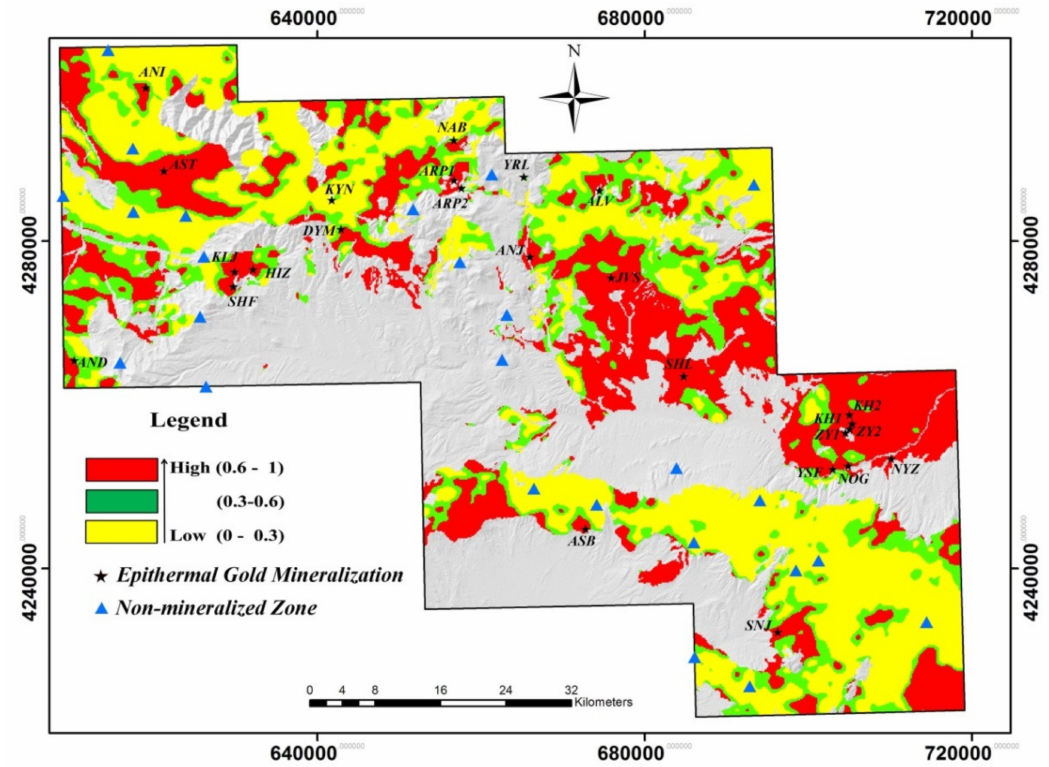
Figure 13. Mineral potential map of the Ahar-Arasbaran region produced using the NB classifier. For abbreviation to epithermal gold mineralizations, refer to Figure